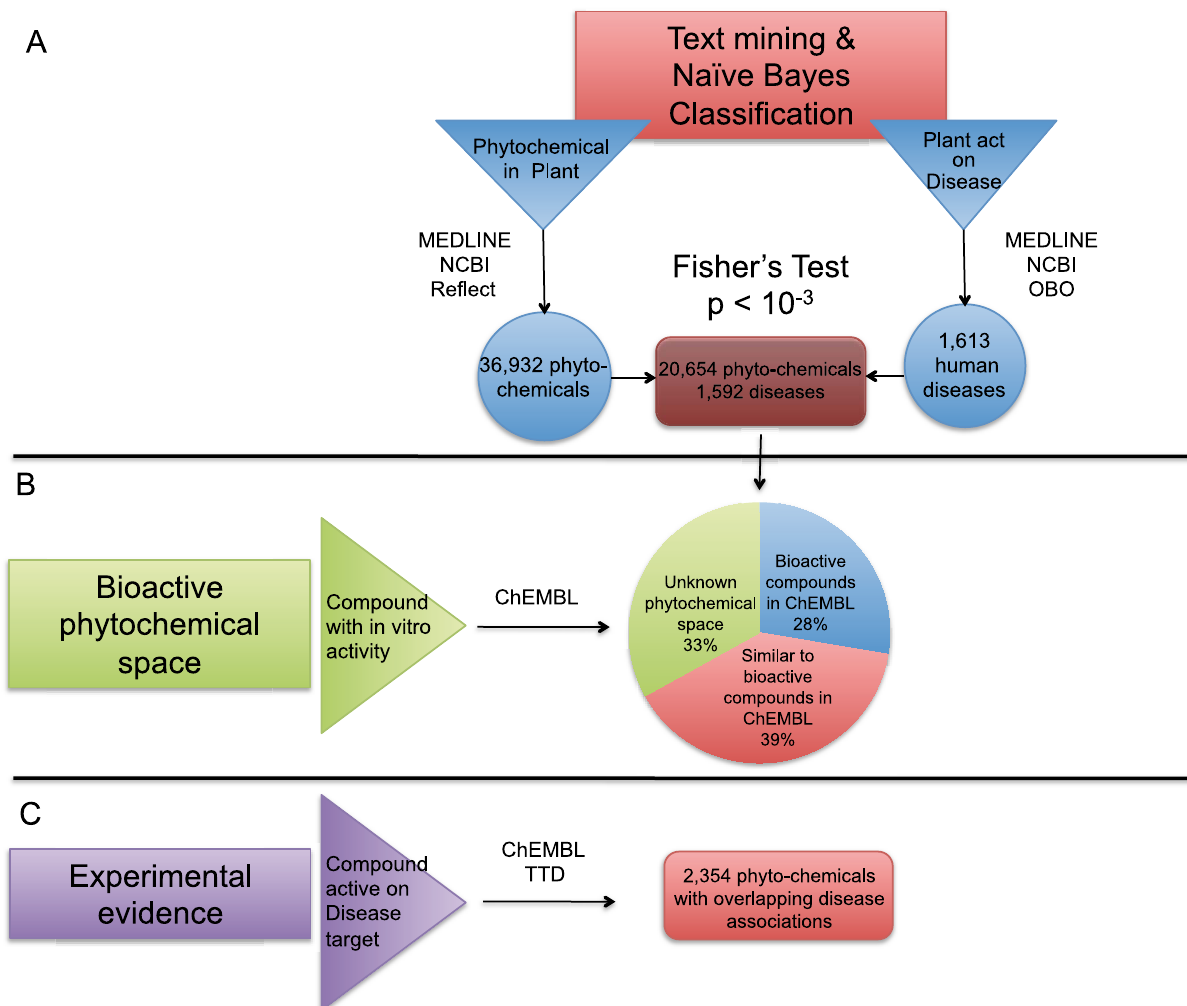
Figure 4. Association of phytochemicals to human disease phenotypes. The flow diagram illustrates the approach we followed for associating phytochemicals to human disease phenotypes. a) In the phytochemical - food and food - disease relations that we extracted by text mining, there are 7,077 plants with both phytochemical and human disease annotation. We used Fisher’s exact test to identify statistically significant correlations between phytochemical and human disease phenotypes. At a 5% false discovery rate we identified 20,654 phytochemicals associated to 1,592 human disease phenotypes. b) 5,709 of the text-mined phytochemicals have been tested experimentally on a biological target and the activity data have been deposited in ChEMBL. For the remaining two thirds of the compounds, 8,113 phytochemicals are structurally similar to compounds with known protein targets (estimated with a Tanimoto coefficient . 0.85), indicating similar bioactivity. The rest of the compounds, 6,832 phytochemicals, are not similar to any known bioactive compound and belong to a hitherto unexplored phytochemical space. c) We used the Therapeutic Targets Database to annotate the protein targets from ChEMBL to diseases. From the 5,709 phytochemicals that are included in ChEMBL, 2,354 are active against a biological target that is relevant for the same disease as the one we have predicted.